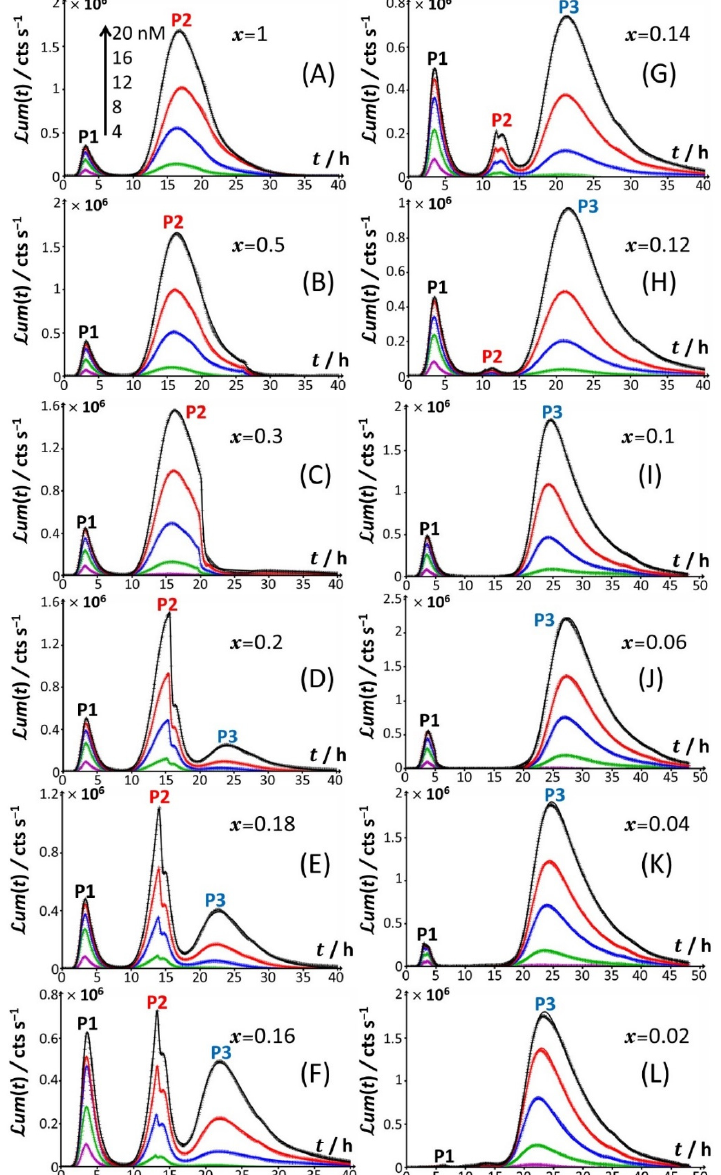
Figure 2. Time-dependence of bioluminescence ( ℒ um ( t )) measured for the Cd-responsive E. coli biosensor as a function of total Cd concentration in the range of 0–20 nM (indicated) in nGGM media supplemented with 0.1% tryptone and different concentrations of glucose and xylose, as subsumed in x with 0.02 ≤ x ≤ 1. The scale in Cd concentration and associated color nomenclature specified in ( A ) apply to panels ( B – L ). (+) symbols: experimental data. Lines: reconstruction on the basis of the theory outlined in Section 3. Signals were corrected by point-by-point subtraction of the corresponding cell response measured in the 0 nM Cd concentration. The quality of theoretical reconstructions of the bioluminescence signals normalized following Equation (9) is reflected by the root mean square values reported in Supplementary Table S1.